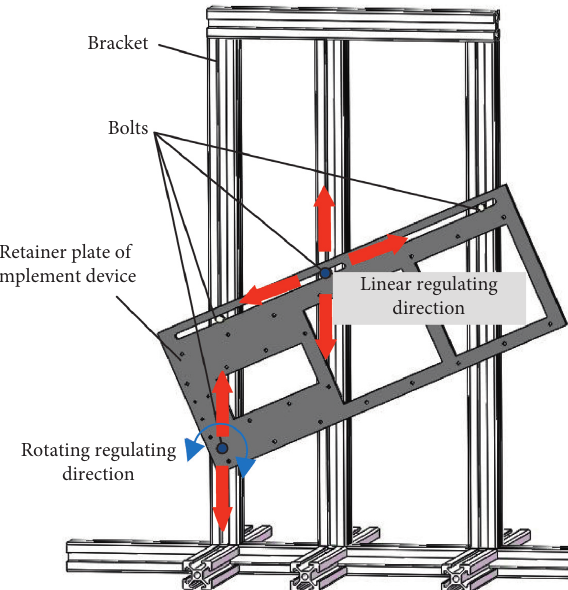
Figure 3: Regulating device for installing angle and height of the robot.